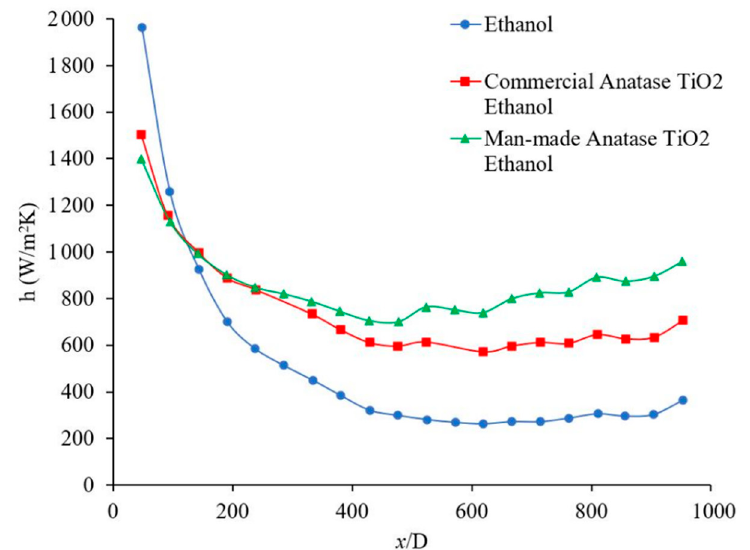
Figure 15. Variation of forced convection heat transfer coefficient as a function of distance for TiO2–ethanol nanofluids. Nanofluid concentration was 1 wt % , and the Reynolds number inside the microchannel was about 153. Comparison between effects of semiconductor anatase TiO 2 nanoparticles made in our research group [40] and commercial anatase TiO 2 nanoparticles.